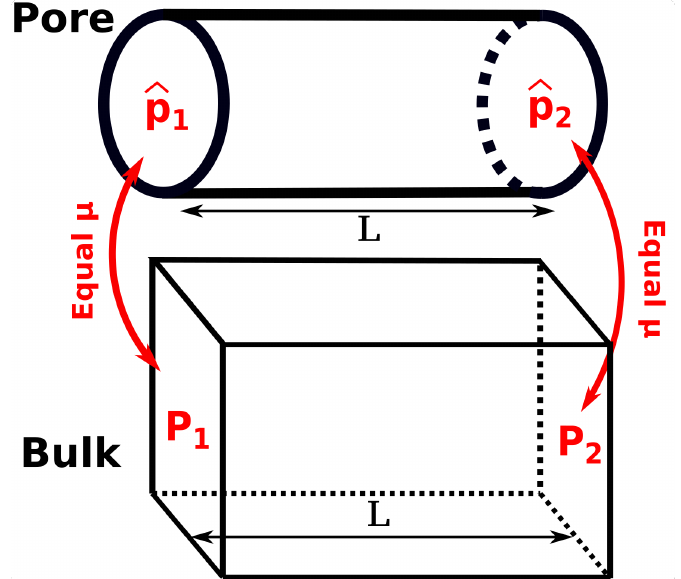
Figure 3. Schematic representation of a bulk fluid in equilibrium with a nanoconfined fluid in a pore. The concept of the ratio of driving forces for mass transport, definition of ratio of driving forces in the two systems,